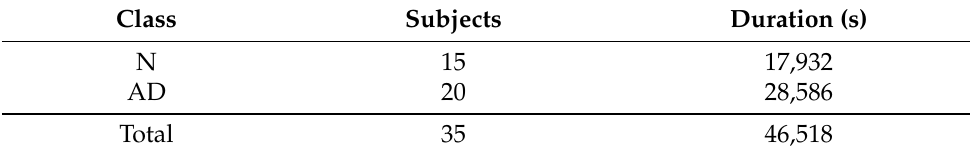
Table 1. Dataset